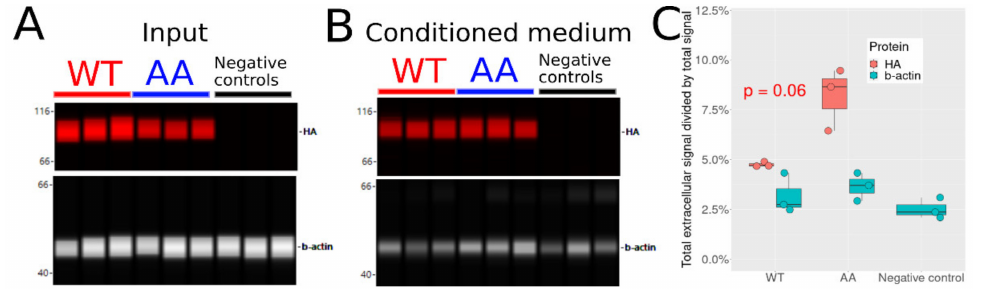
Figure 4. Levels of WT vs. AA in the CM of transfected HEK293T-Hsp90 β KO19 cells. ( A ) CWB detection of HA-tag (red bands) and β -actin (grey bands) in transfected HEK293T-Hsp90 β KO19 cells. Dual detection was performed on the same capillaries by chemiluminescence ( β -actin) or fluorescence (HA-tag). ( B ) CWB analysis of HA-tag and β -actin in CM. ( C ) Total absolute CWB signal in CM divided by total absolute CWB signal (CM plus input). Total absolute signal was adjusted to account for the totality of the sample (it is the expected signal if the whole sample was analyzed at once). Points represent replicates. In red, the p -value from WT vs. AA t -test comparison of HA signal corrected by basal β -actin